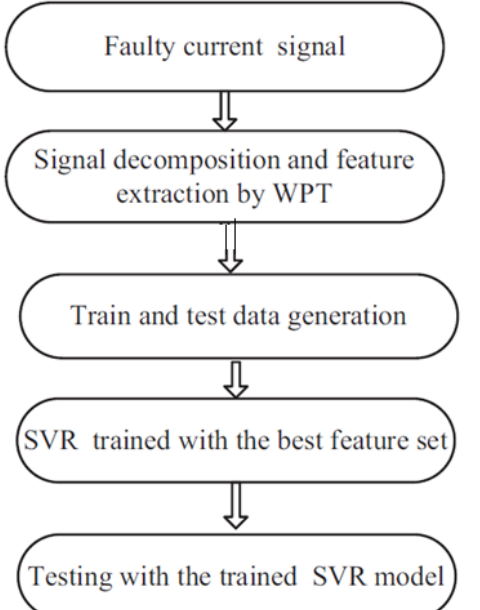
Figure 5. Fault location taxonomy.